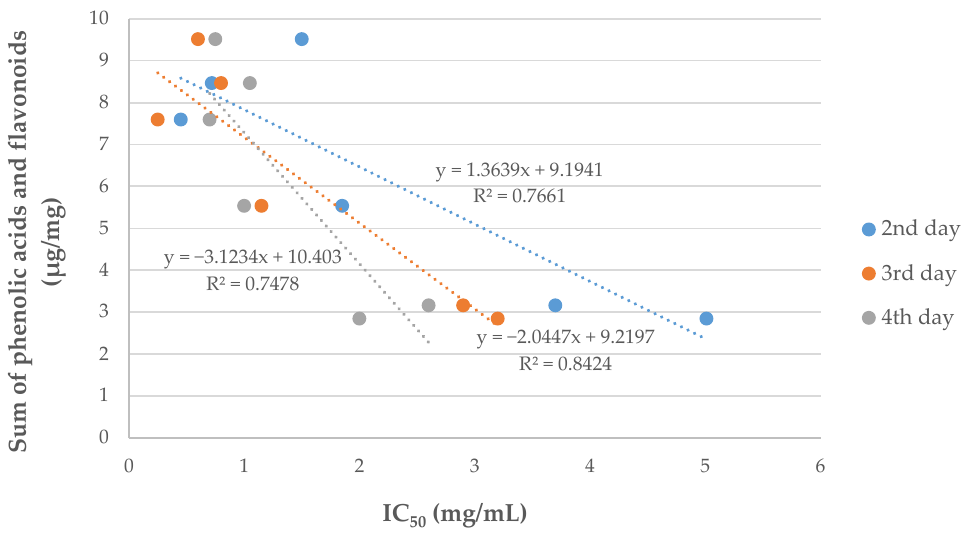
Figure 2. Correlation between IC 50 values and the sum of phenolic acids and flavonoids determined by HPLC method in Eryngium species.